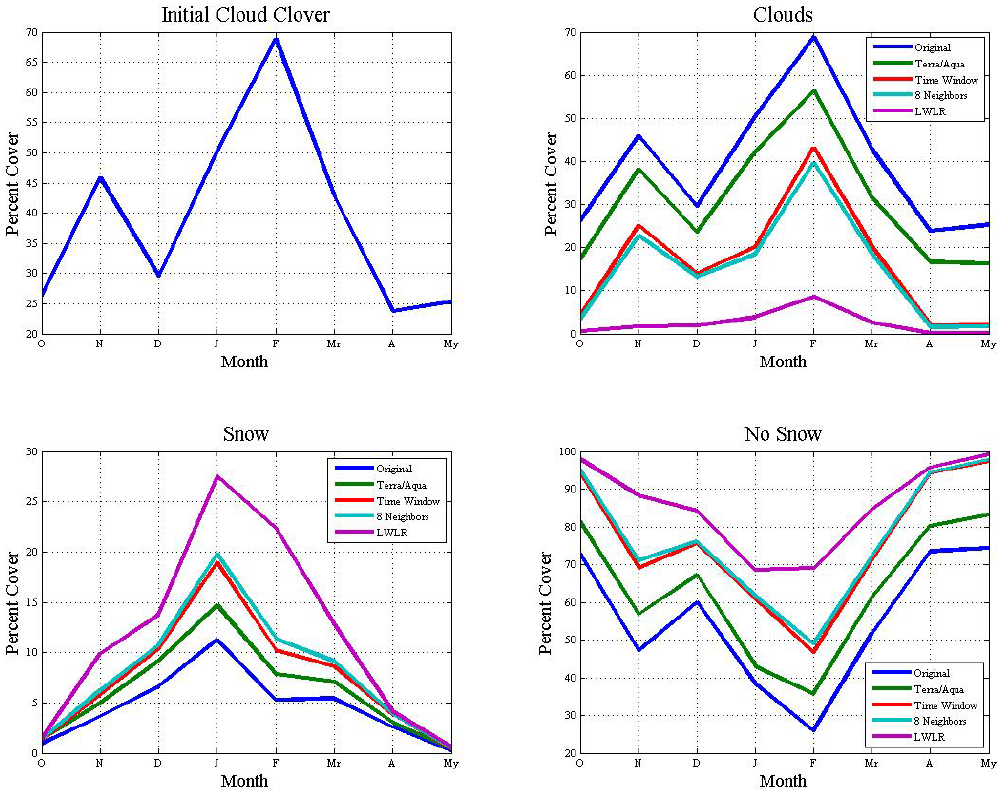
Fig. 6. Progressive improvement obtained by sequential application of the methods and how this improvement distributes across